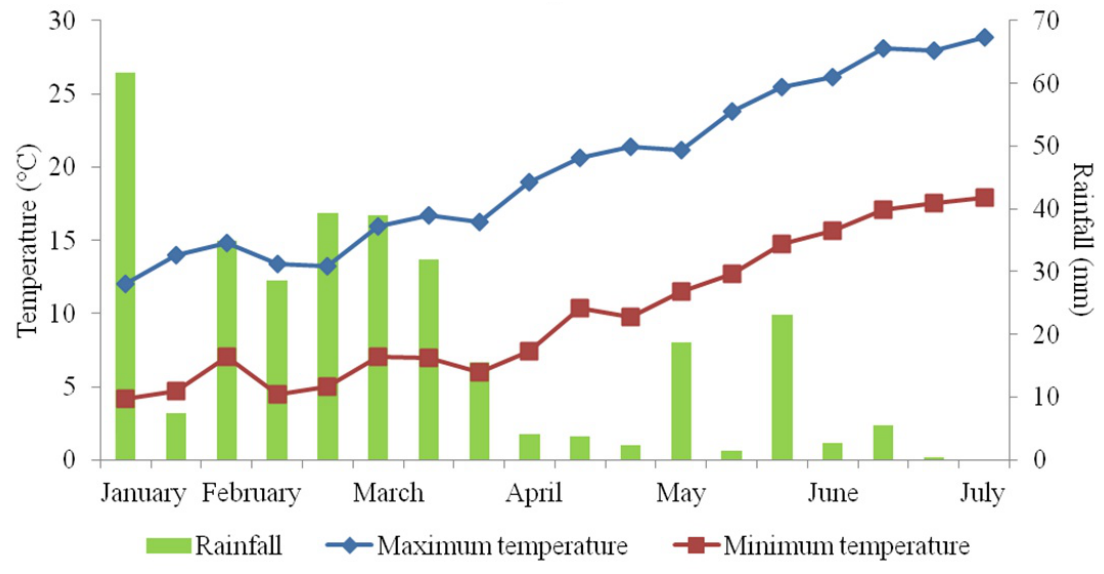
Figure 3. Trend of temperature and rainfall in Portici (Naples, Italy): mean values of 2016–2017 and 2017–2018, from the second 10-day interval of January to the first 10-day interval of July.